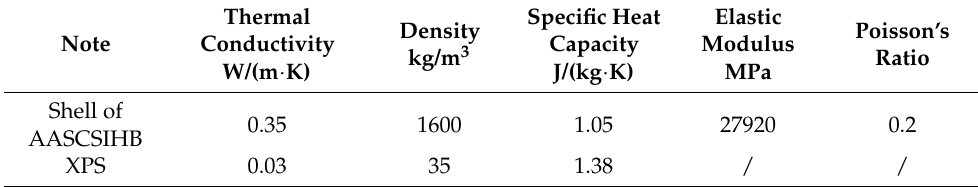
Table 2. Physical parameters of the AASCCIB.